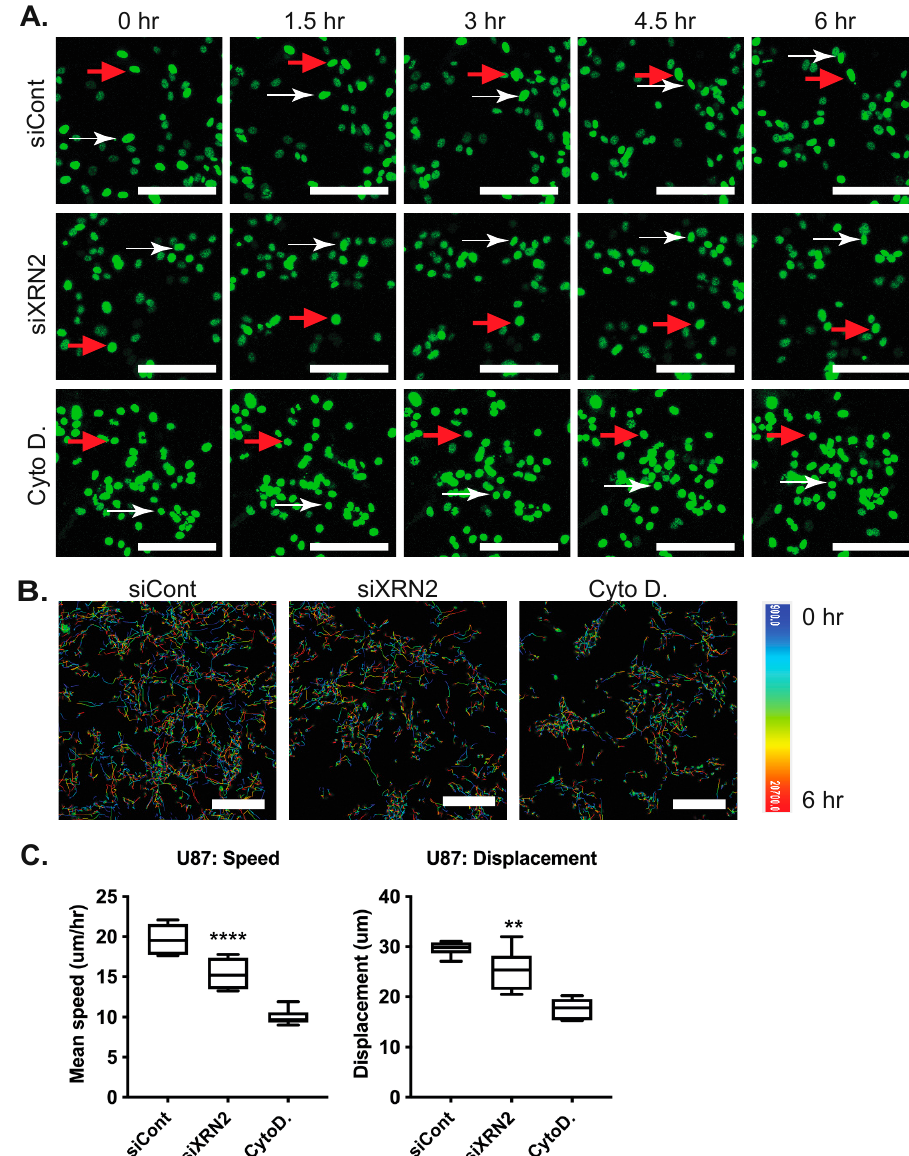
Figure 2. XRN2 is required for GBM cell motility. ( A ) Image stills from live-cell imaging of U87-GFP cells. Arrows track the movement of two representative cells over time. Tracking was over 6 h with images taken at 30-min intervals. ( B ) Positional tracks of U87 H2B-GFP cells during the 6 h live-cell imaging. White marks the position of the cells at the beginning of time to red, the position of the cells at the end of imaging. ( C ) Quantification of U87-GFP tracking. Changes in speed and displacement upon XRN2 knockdown by siRNA are shown. Scale bar is 100 micron. ** p -value ≤ 0.01, **** p -value ≤ 0.0001. The Students t -test was used for statistical analysis.